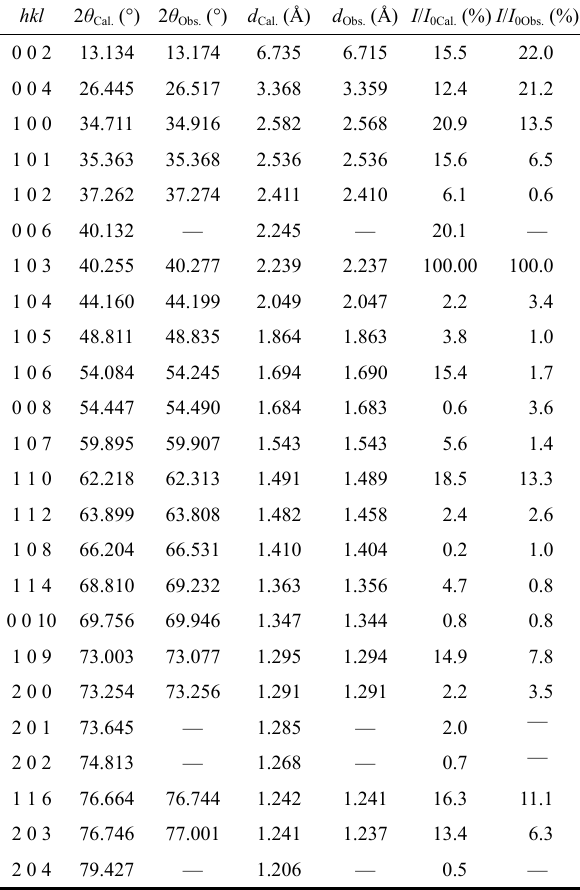
Calculated and experimental data of reflections, 2 θ , d -spacings, and intensities of V 2 SnC. The peaks of (006), (201), (202), and (204) were not observed due to their low intensities